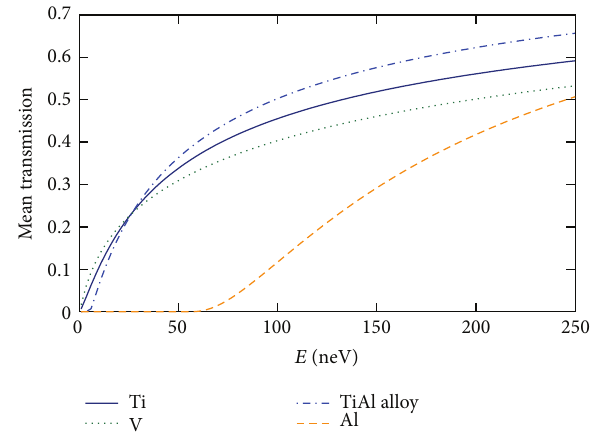
Figure 8: An analytical calculation of the probability of transmis- sion of UCNs through two foils (15 𝜇 m each for Ti, V, and TiAl alloy, 30 𝜇 m each for Al) for an isotropic UCN gas as a function of UCN